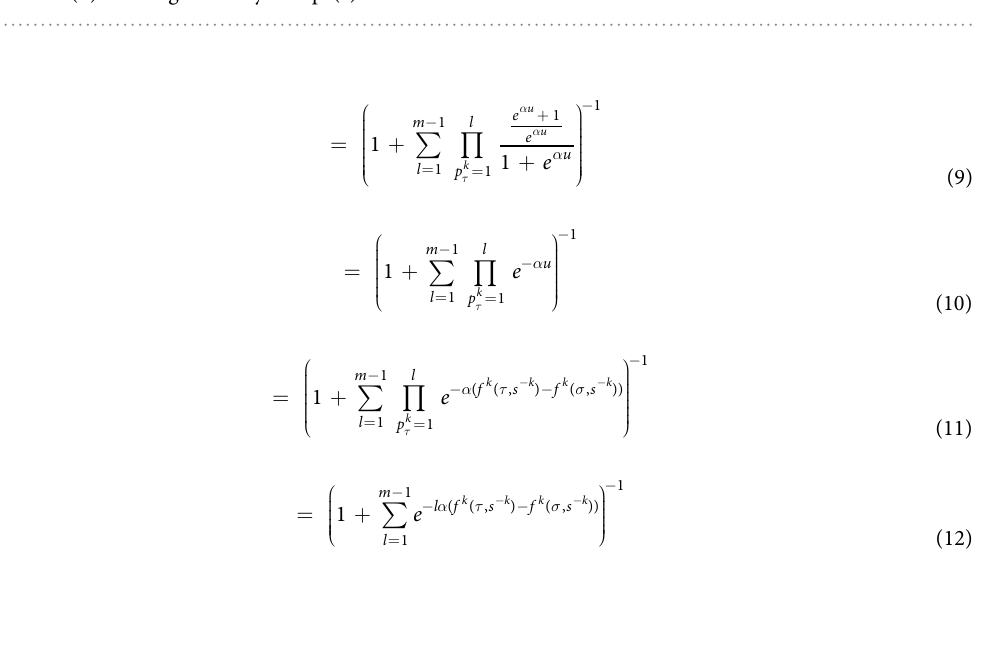
Figure 14. 3-player Kuhn poker (ranking conducted on all 64 pure strategy profiles). ( a ) Discrete-time dynamics. ( b ) Ranking-intensity sweep. ( c ) α -Rank